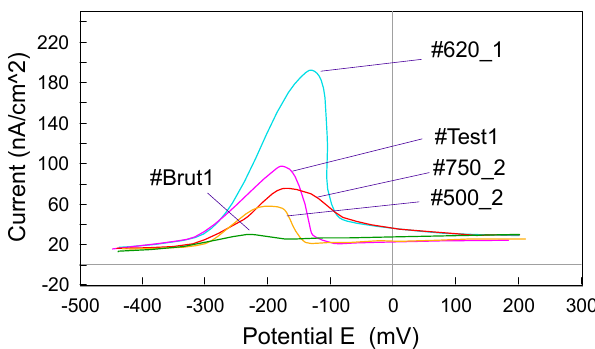
Figure 20. Potentio kinetic reactivation curves recorded for #Brut 1, #Test 1, #500_1, #620_2, and #750_2.